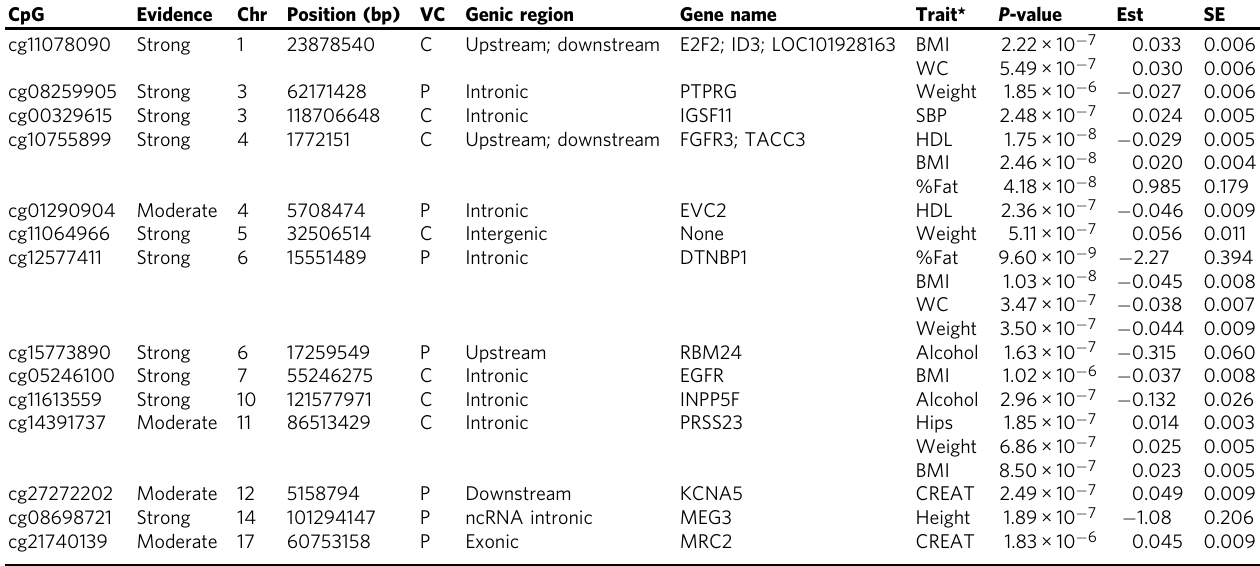
Table 4 Associations between POE CpGs and traits signi fi cant at the multi-trait level CpG Evidence Chr Position (bp) VC Genic region